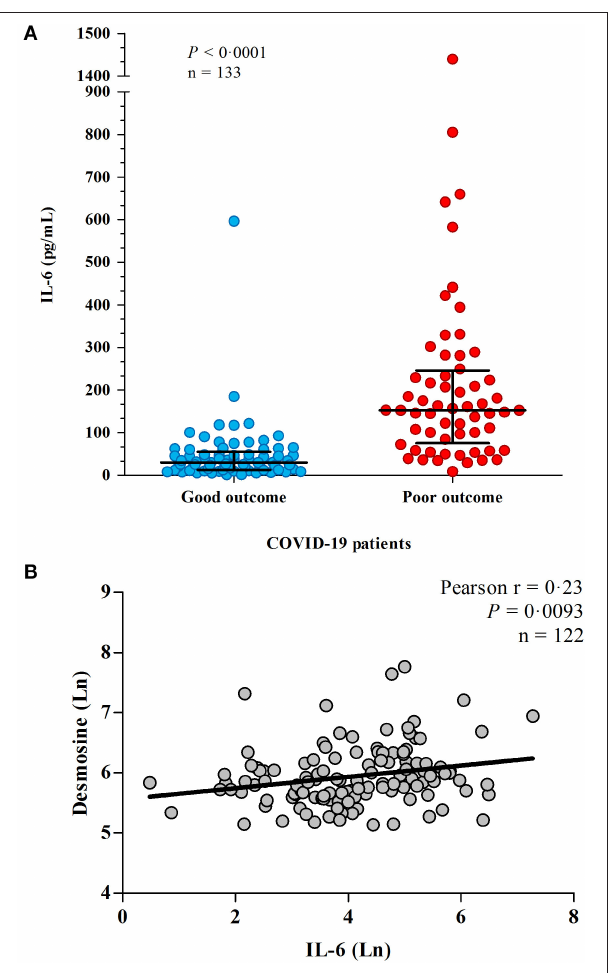
FIGURE 1 | (A) IL-6 levels in hospitalized patients with COVID-19. IL-6 levels were measured in plasma from 133 patients. Patients outcome was defined as “good” when they survived without the need of invasive ventilation, or “poor” when they needed supportive invasive ventilation and/or deceased. (B) The association between IL-6 and elastic fiber degradation. Correlation between IL-6 and desmosine in 122 COVID-19 patients, both log transformed. Line shows the result of a linear